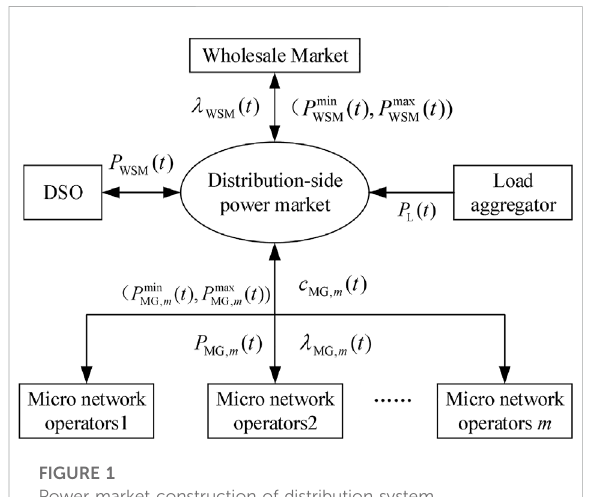
FIGURE 1 Power market construction of distribution system.